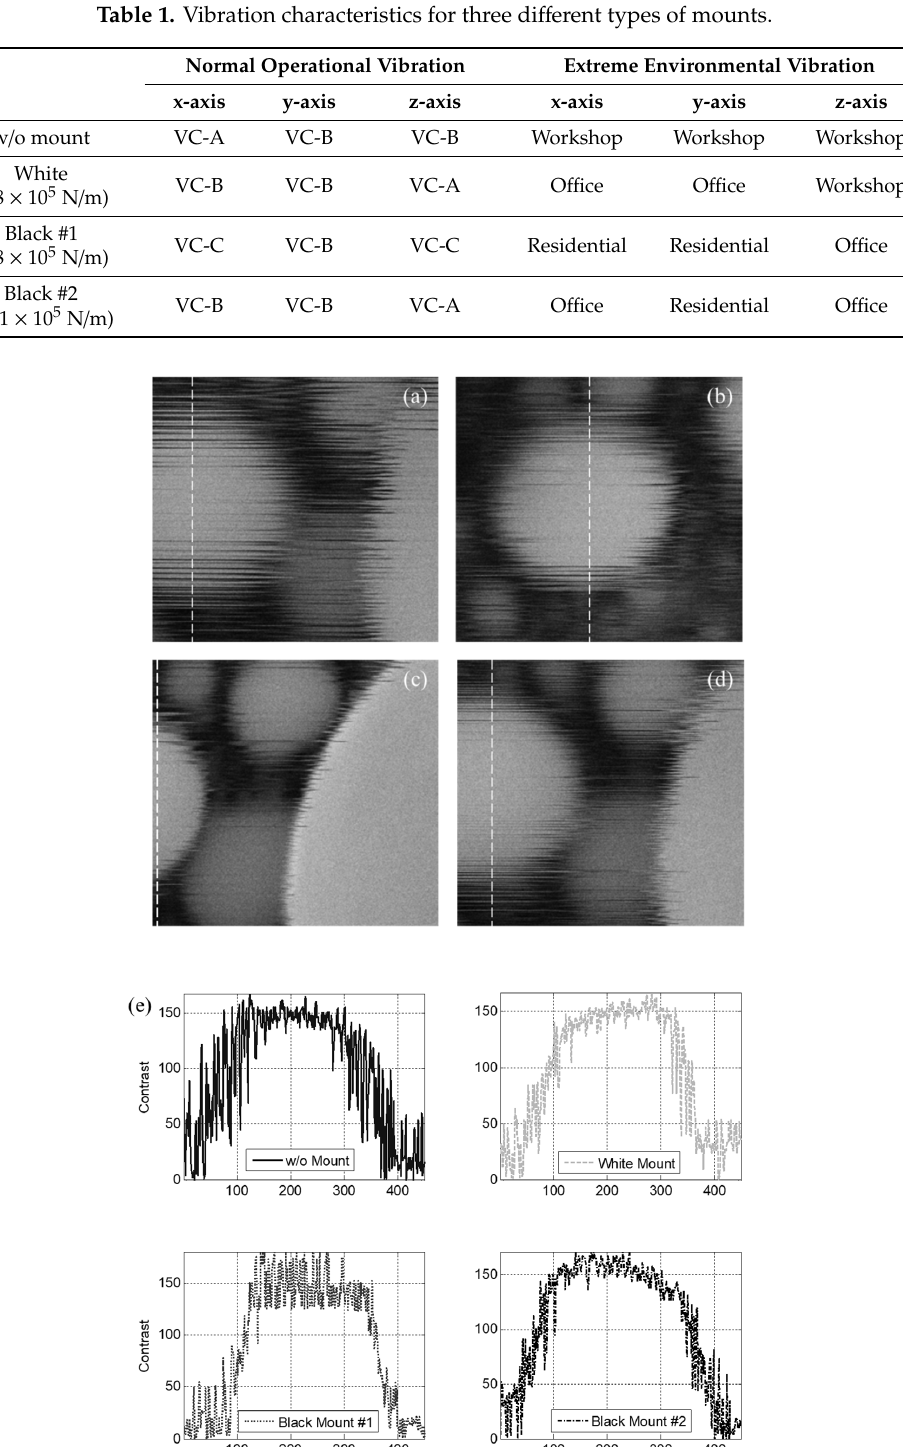
Figure 10. Specimen pattern images measured with ( a ) no mount, ( b ) white mount, ( c ) black mount #1, and ( d ) black mount #2 under extreme environmental vibration; ( e ) contrast variations in the specimen pattern